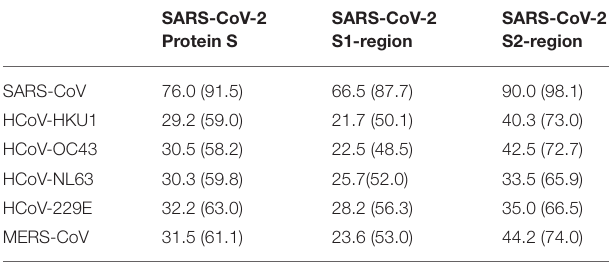
TABLE 3 | Protein S—aminoacidic identity and similarity scores between human coronaviruses and SARS-CoV-2S